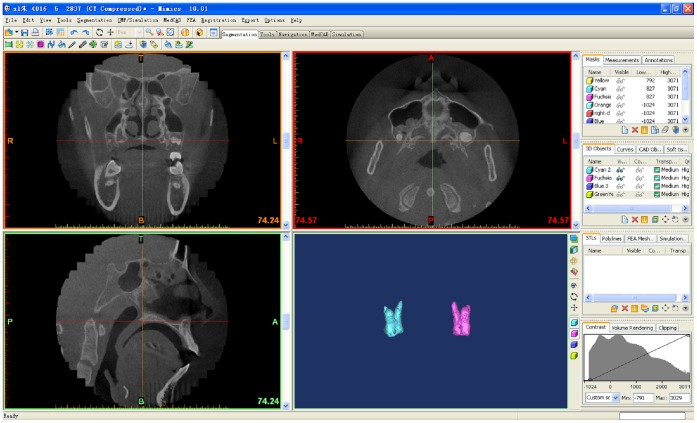
Segmentation of the upper first molar.